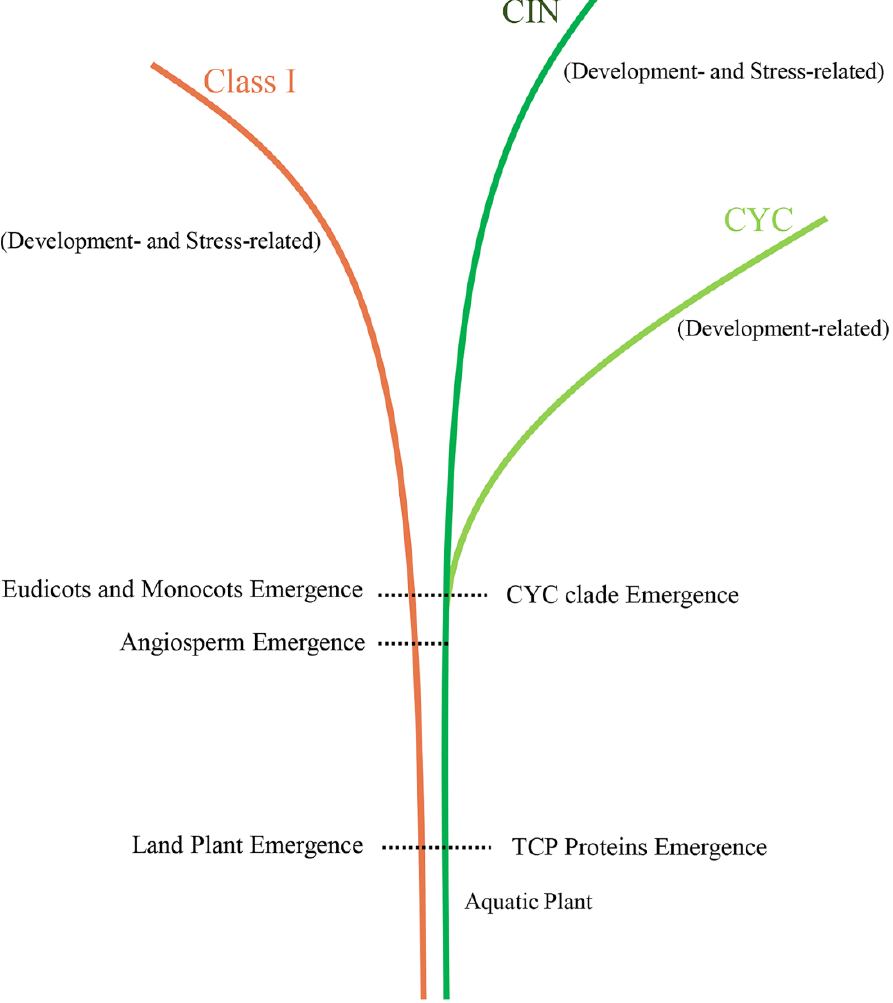
Figure 7. Evolutionary scenario of TCP genes in land plants. Dotted lines indicate the absence of TCP 534 proteins in aquatic plants. 535